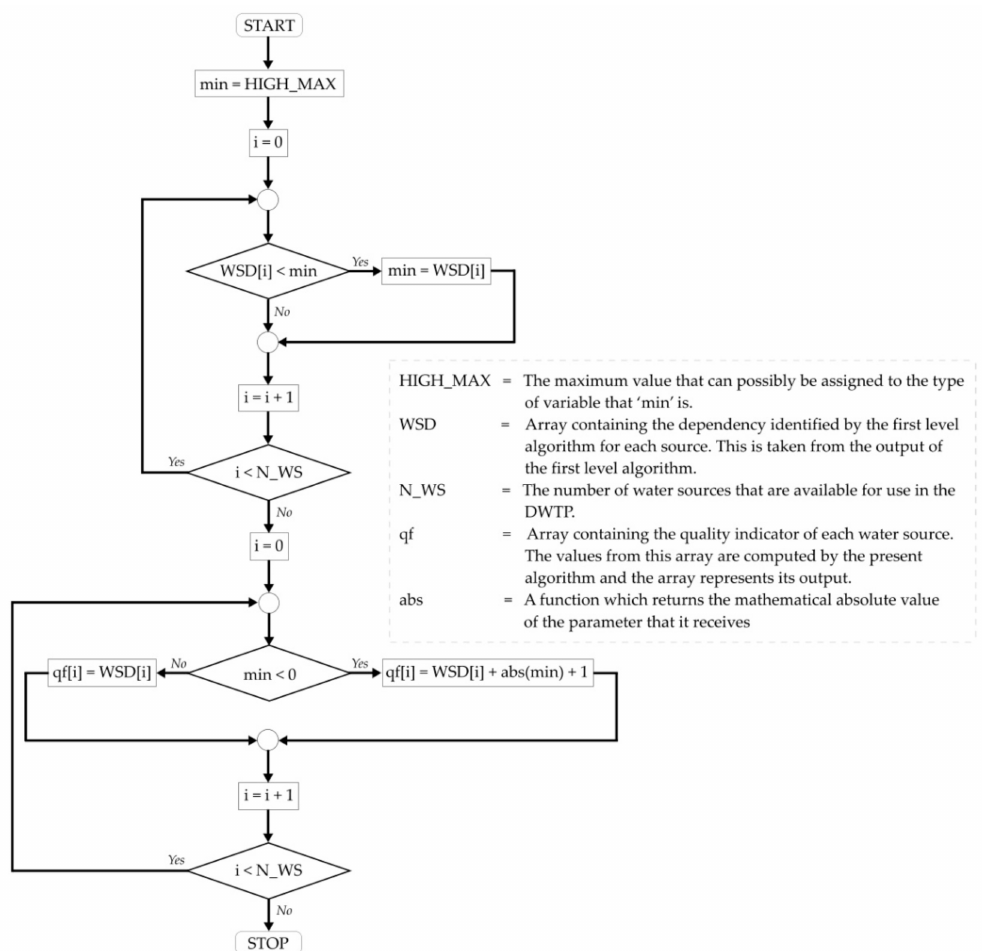
Figure 5. The implemented algorithm which determines q f from the results of the first level depen- dencies identification